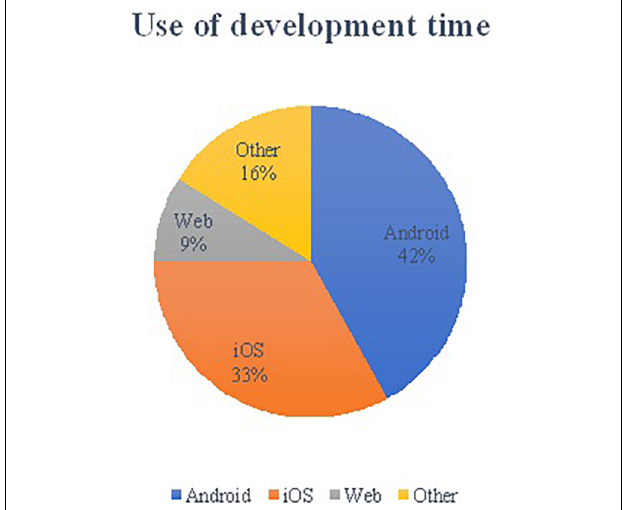
FIGURE 5 | Use of development